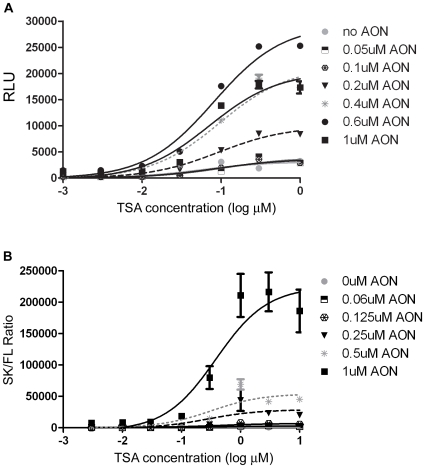
TSA enhances AON-induced exon skipping of hE72-Luc DMD minigene reporter construct in HEK 293 cells.(A) HEK 293 cells were transiently transfected with hE72-Luc and 0–1 µM hE72 AON 24 h prior to addition of 0–1 µM TSA in 1536-well format. Luciferase activity (RLU = relative luciferase units) was measured 24 h after compound addition (48 h post-transfection) and shows a positive trend with AON concentration that is enhanced with TSA treatment. Inhibition of signal begins to occur at 1 µM AON (black squares). Data points are an average of 6 replicates and error bars represent standard deviation. (B) HEK 293 cells were transiently transfected with hE72-Luc and 0–1 µM hE72 AON 6 h prior to addition of 0–10 µM TSA in 24-well format prior to qPCR analysis of transcripts 24 h after compound treatment. An increase in the ratio of exon skip (SK) to full-length (FL) transcripts in seen with increasing AON concentration that is enhanced with TSA treatment, indicating it is not a general increase in transcriptional activity. Data points are an average of 5 replicates and error bars represent standard deviation.